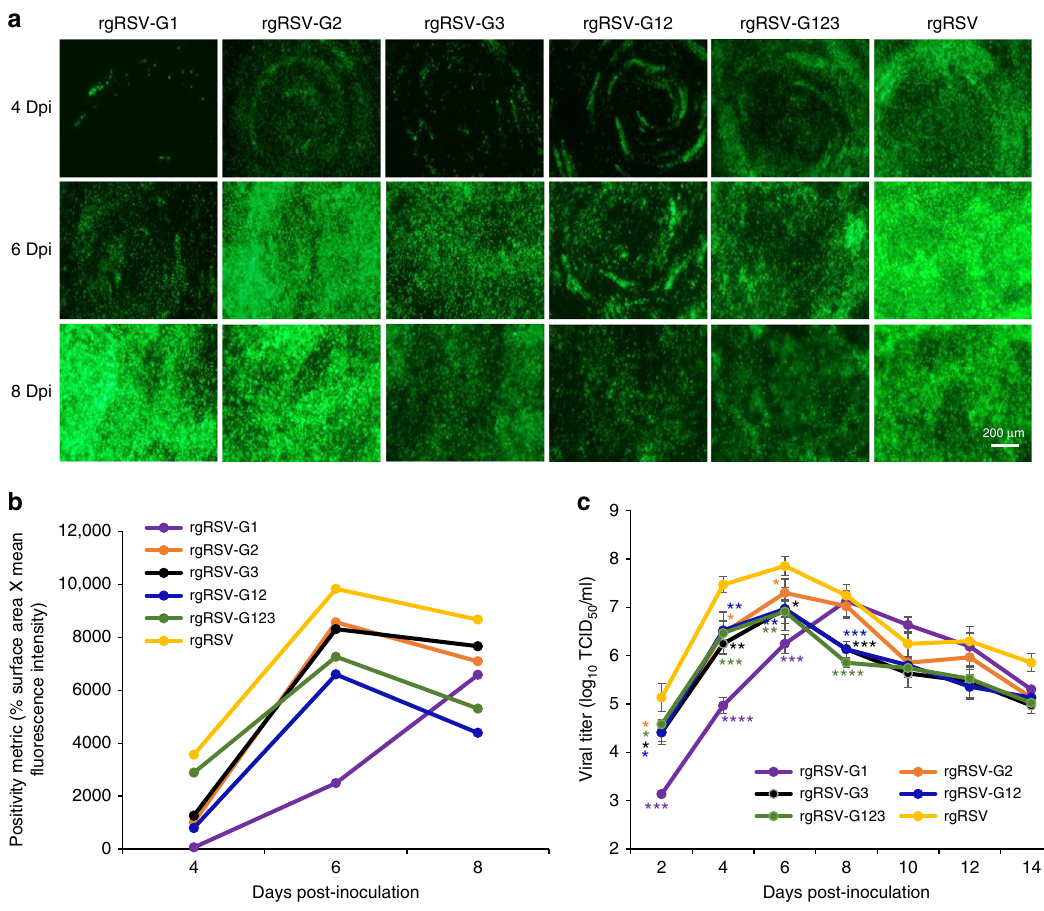
Fig. 8 m 6 A-abrogating RSV mutants have defects in replication in HAE culture. a Spreading of m 6 A mutated rgRSVs in HAE culture. HAE cultures were infected by 800 TCID 50 of each rgRSV. At the indicated time, virus spreading was monitored by fl uorescence microscopy. Representative micrographs with ×4 magni fi cation (scale bar of 200 μ m) at each time point are shown. b Quanti fi cation of GFP signal in HAE culture. GFP signal was quanti fi ed by Image J software, and data are expressed as mean of three transwells of HAE culture, and are the representatives of three independent experiments. c Virus release from m 6 A mutated rgRSV-infected HAE culture. HAE cultures were infected by 800 TCID 50 of each rgRSV. After virus inoculation, supernatants were collected every 2 days until day 14 post-inoculation. Infectious virus in supernatants was determined by TCID 50 assay. Viral titers are the geometric mean titer (GMT) of three independent experiments ± standard deviation. The P value (Student ’ s t -test) for rgRSV-G1 at days 2, 4, and 6